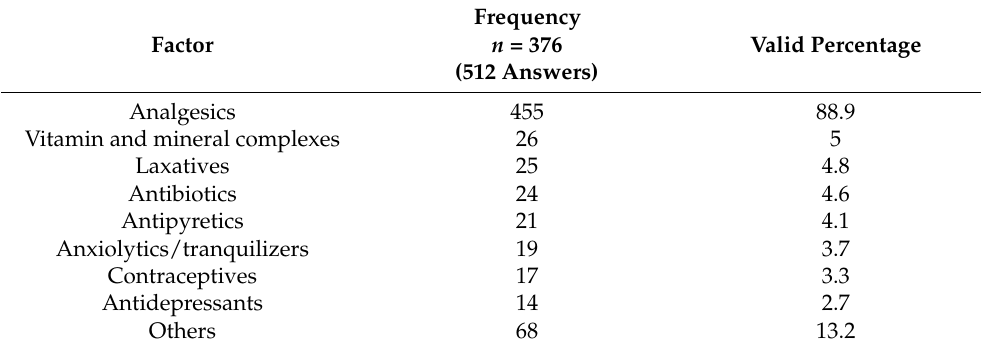
Table 4. Drugs used for self-medication.